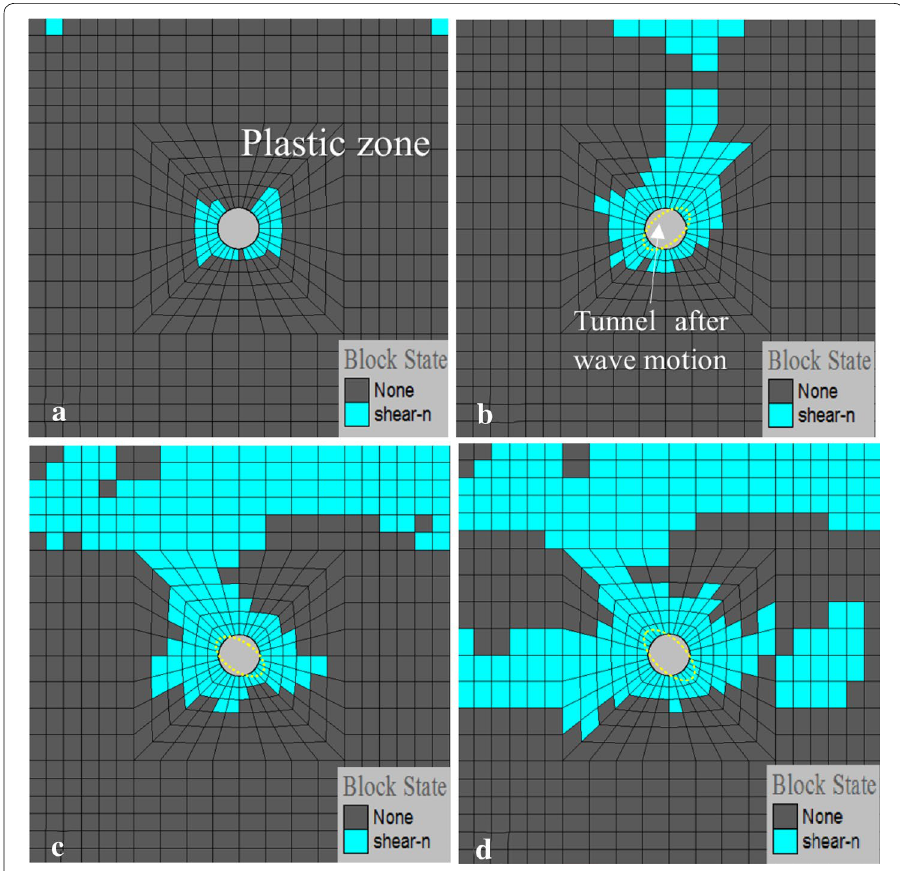
Fig. 15 Expansion of yielding zone vs. PGA. a Static, b PGA